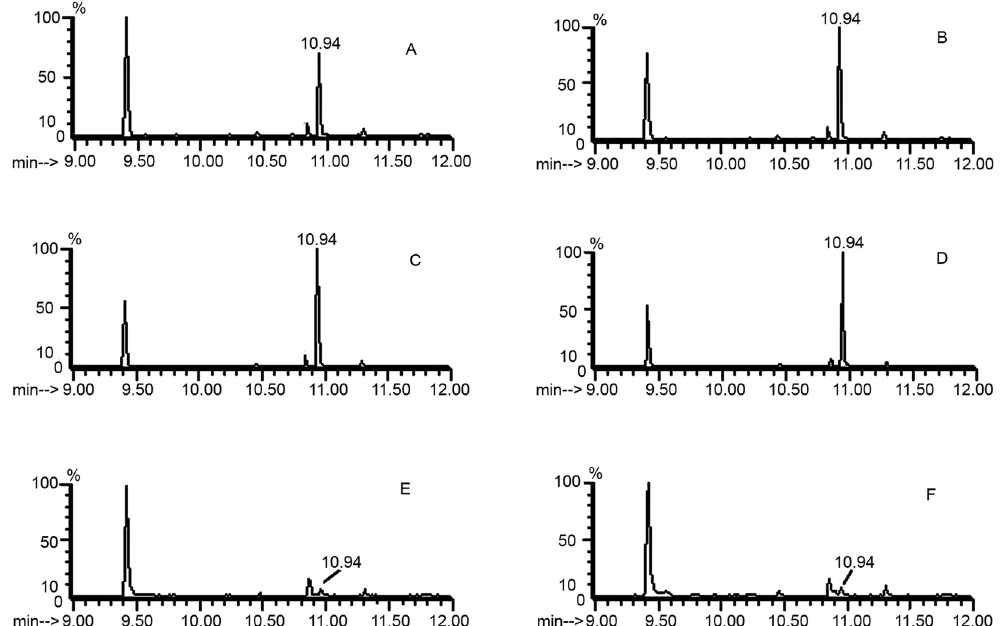
Figure 2. Analysis of the volatiles from aphids under different rearing conditions by GC-MS. ( A ) The volatiles from 10 A. gossypii aphids reared on cotton plants. ( B ) The volatiles from 10 A. gossypii aphids reared on artificial diets (F 17 ). ( C , D ) The volatiles from 10 A. gossypii aphids treated with antibiotics for 14 days and then reared on antibiotic-free diets for 10 or 22 additional days, respectively. ( E , F ) The volatiles from single A. gossypii aphid reared on cotton plants and artiicial diets, respectively. The retention time for ( E )- β - farnesene is